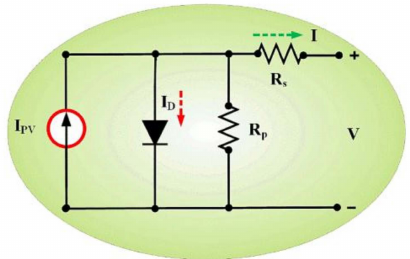
Figure 2. Circuit for the modelling of a single diode PV